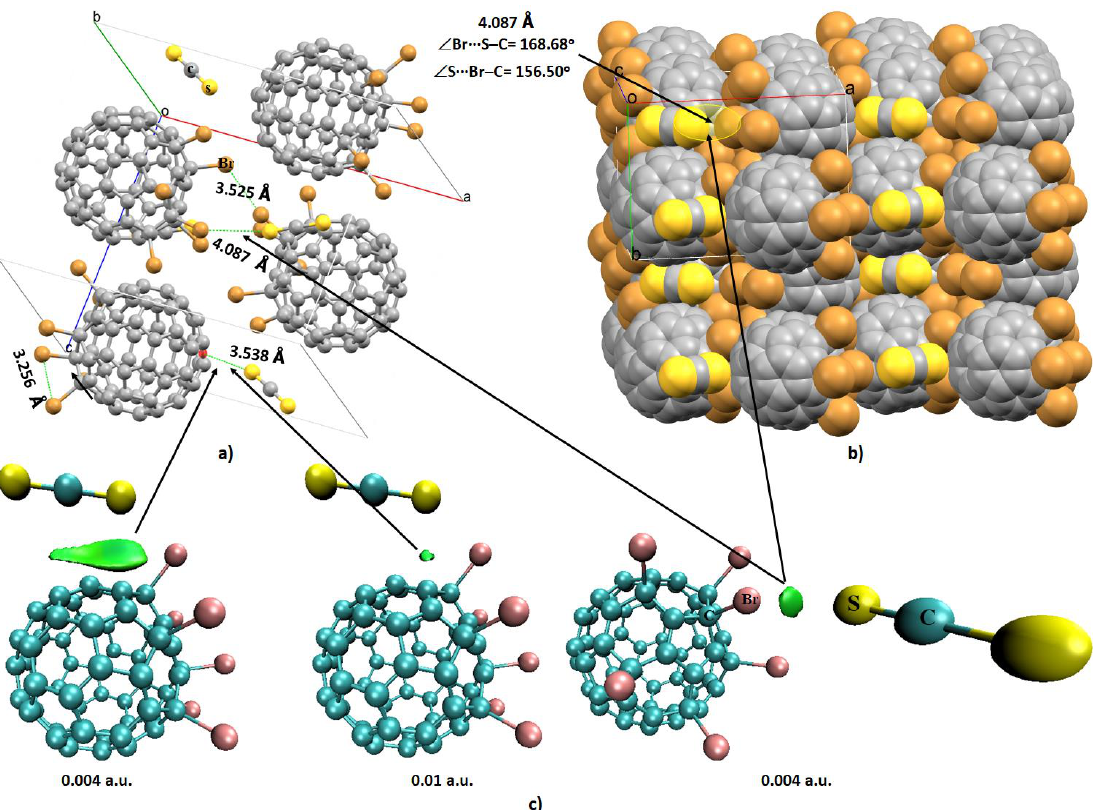
Figure 16. The ( a ) unit cell ball-and-stick and ( b ) 2 × 2 supercell space-filling models of hexabromofullerene carbon disulfide crystal (CSD ref: YAYNOC). ( c ) Specific IGM representation of bonding interactions between the S atom in CS 2 and the Br and (C=C) π (and C 6 ring) of the hexabromo-substituted C 60 , obtained with different isovalues. Selected intra- and intermolecular distances (and angles) are shown in ( a ).